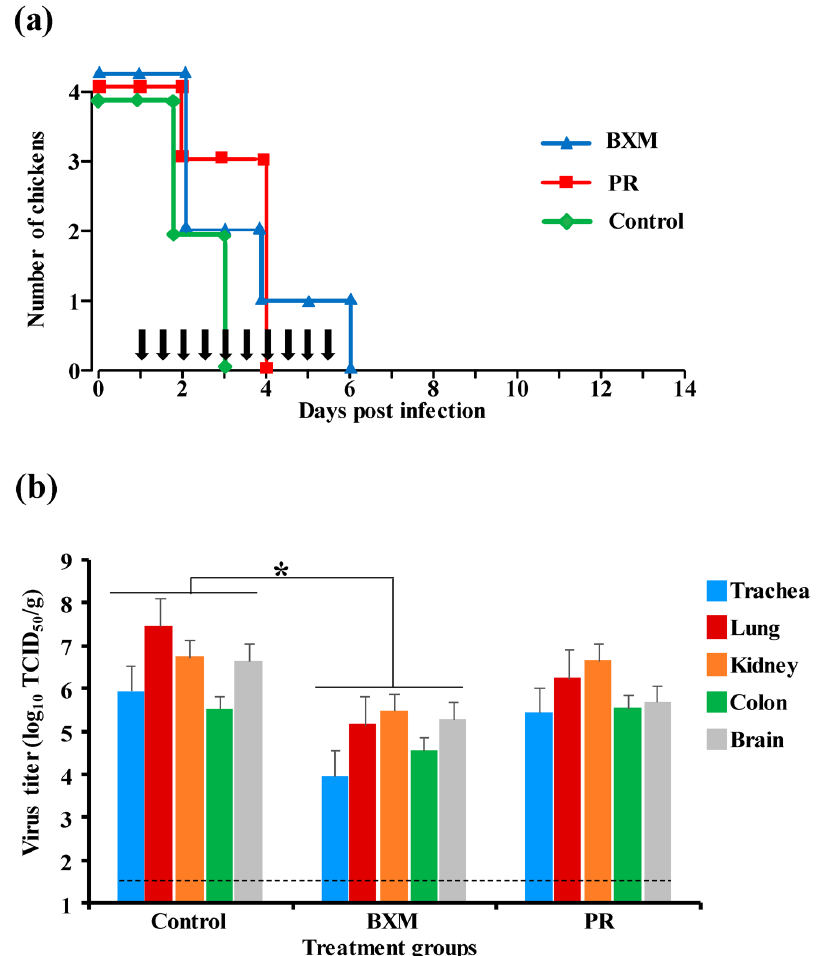
Figure 2. E ff ects of delayed treatment with multiple-dose administration of BXM or PR in chickens infected with HPAIV, A / BS / Akita / 1 / 16. Eight chickens per group were infected with 10 CLD 50 / 100 µ L (10 5.3 EID 50 ) of the HPAIV and treated with 20 mg / kg of either BXM or PR for 24 h to 5 days post-infection; the untreated group was kept as the control. ( a ) Survival and clinical signs of half the infected birds was followed until 14 dpi; vertical black arrows indicate the treatment schedule. ( b ) Virus recovery from organs collected at 3 dpi from four chickens of each group was assessed in monolayer MDCK cells. The viral titer calculated as the average ( n = 4) of each organ in the treatment group was compared to that of the control group; bar indicates the standard deviation. (*, p <